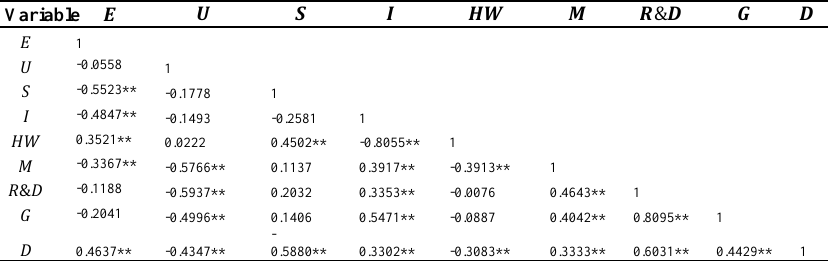
Table 2. Correlation matrix of the dependent variable and explanatory